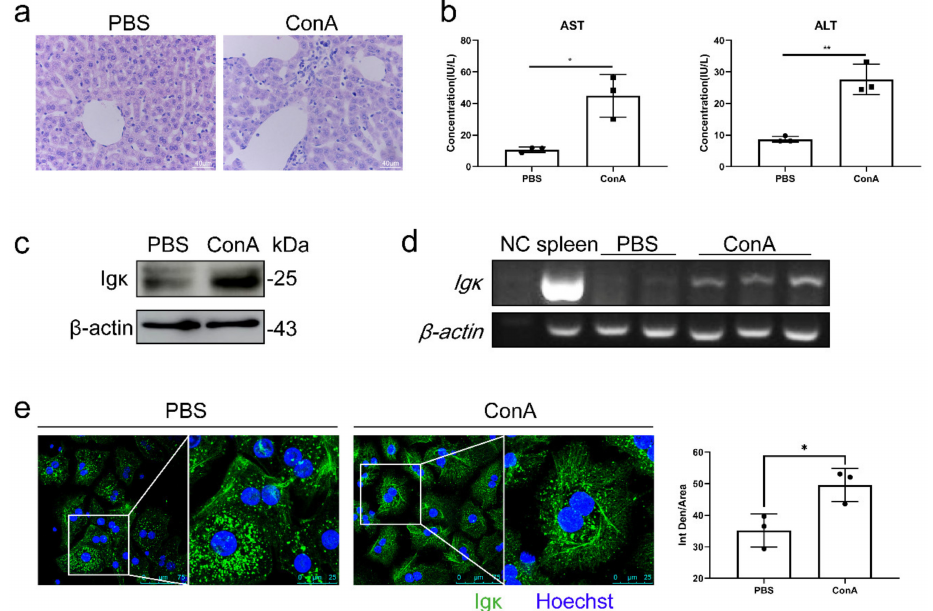
Figure 2. Upregulation and subcellular localization of Ig κ in concanavalin A (ConA)-induced liver injury in µ MT mice. The µ MT mice were treated with ConA or PBS and sacrificed 24 h later. ( a ) Liver sections of µ MT mice were stained with hematoxylin and eosin and representative images are shown. ( b ) Levels of serum alanine aminotransferase and aspartate aminotransferase. * p < 0.05; ** p < 0.01. ( c ) Western blot and ( d ) Reverse-transcription PCR analysis of Ig κ and β -actin in primary hepatocytes. ( e ) Immunofluorescence staining of Ig κ in primary hepatocytes. Quantification of fluorescence